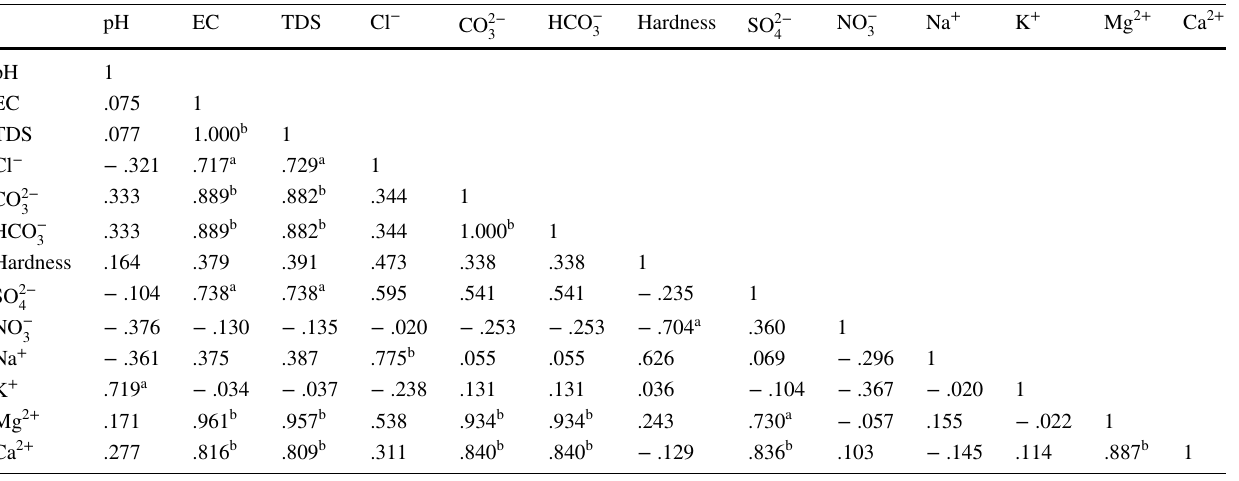
a Correlation is significant at the .05 level (2-tailed) b Correlation is significant at the .01 level